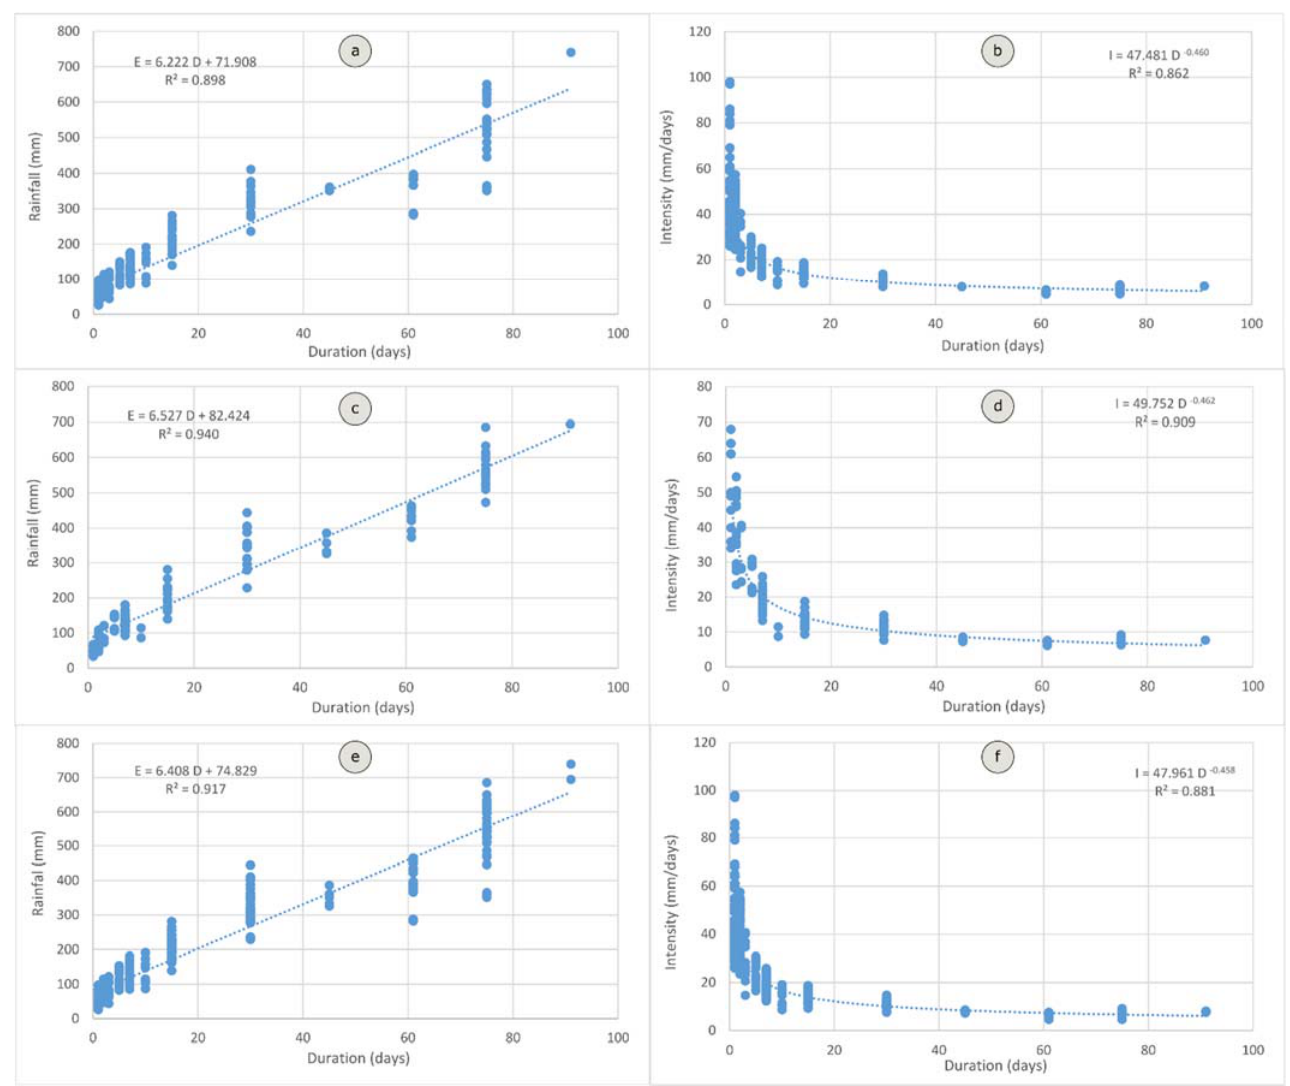
Figure 8. Rainfall thresholds: ( a ) E–D for lower magnitude incidences; ( b ) I–D for lower magnitude incidences; ( c ) E–D for higher magnitude incidences; ( d ) I–D for higher magnitude incidences; ( e ) E–D for all incidences; and ( f ) I–D for all incidences.